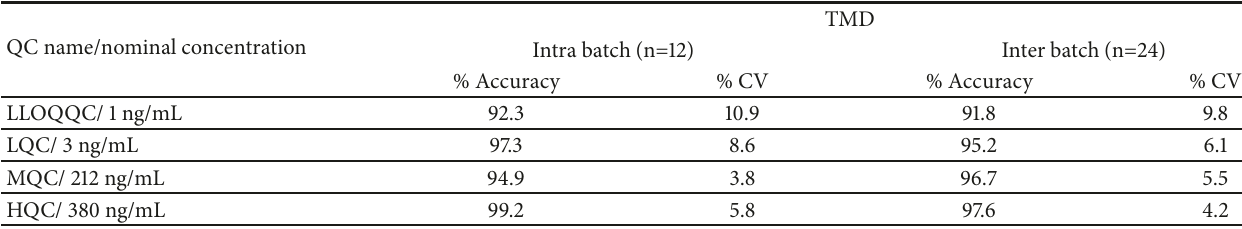
Table 2: Precision and accuracy results of TMD.